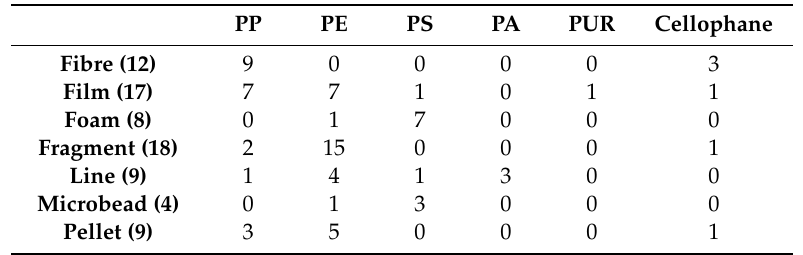
Table 2. Polymer composition of a subset (n = 77) of the microplastic particles encountered in sediment and water at the four estuaries sampled based on